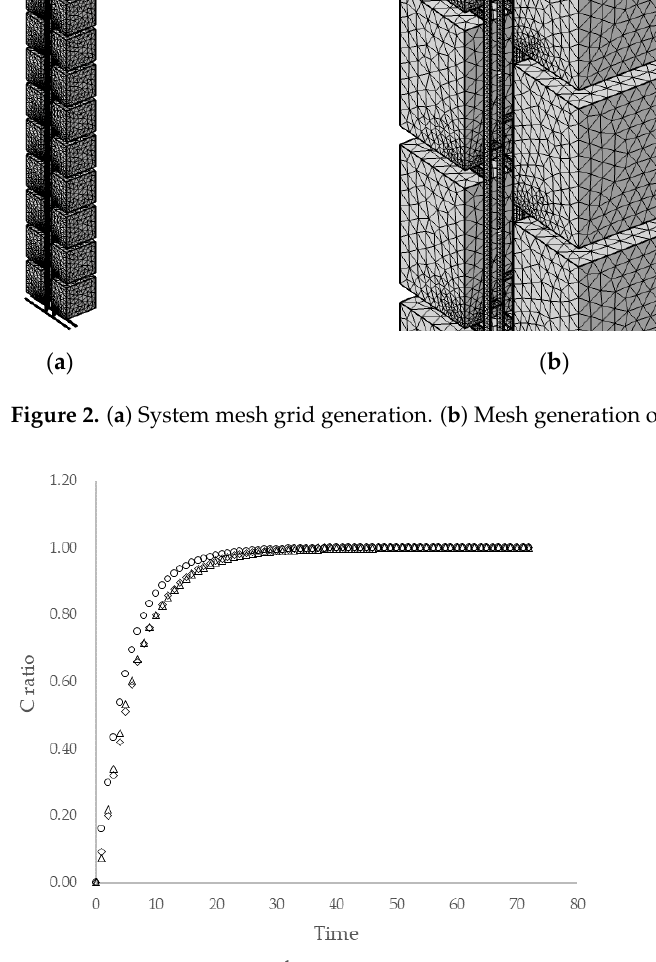
Figure 3. Mesh test using C ratio as benchmark.